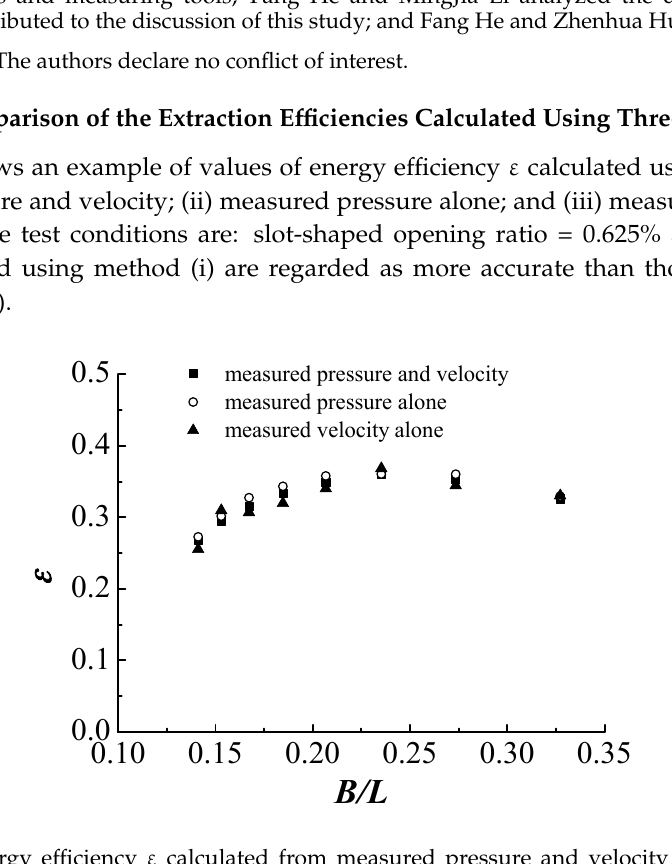
Figure A1. Energy efficiency ε calculated from measured pressure and velocity (solid squares), measured pressure alone (circles), and measured velocity alone (solid triangles); slot-shaped opening ratio = 0.625% and draft = 10 cm.